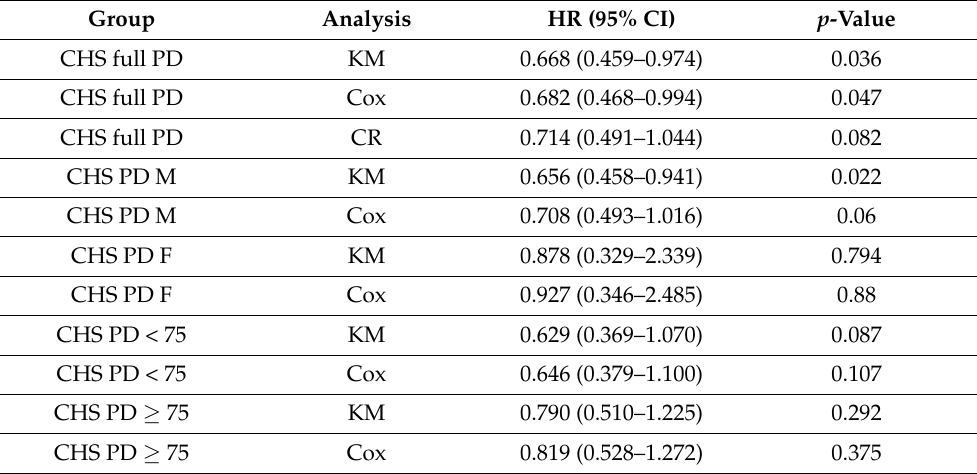
Table 4. Risk assessment of PD in CHS by Kaplan–Meier (KM), Cox proportional hazards regression (Cox), and competing risk analysis